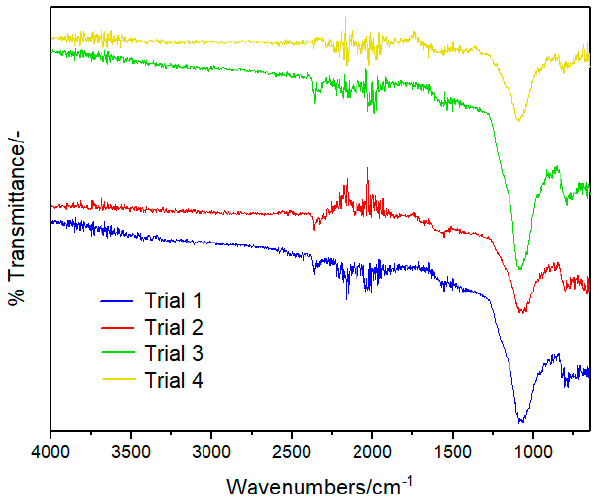
Figure 11. ATR-FTIR spectra of pyrolyzed samples.